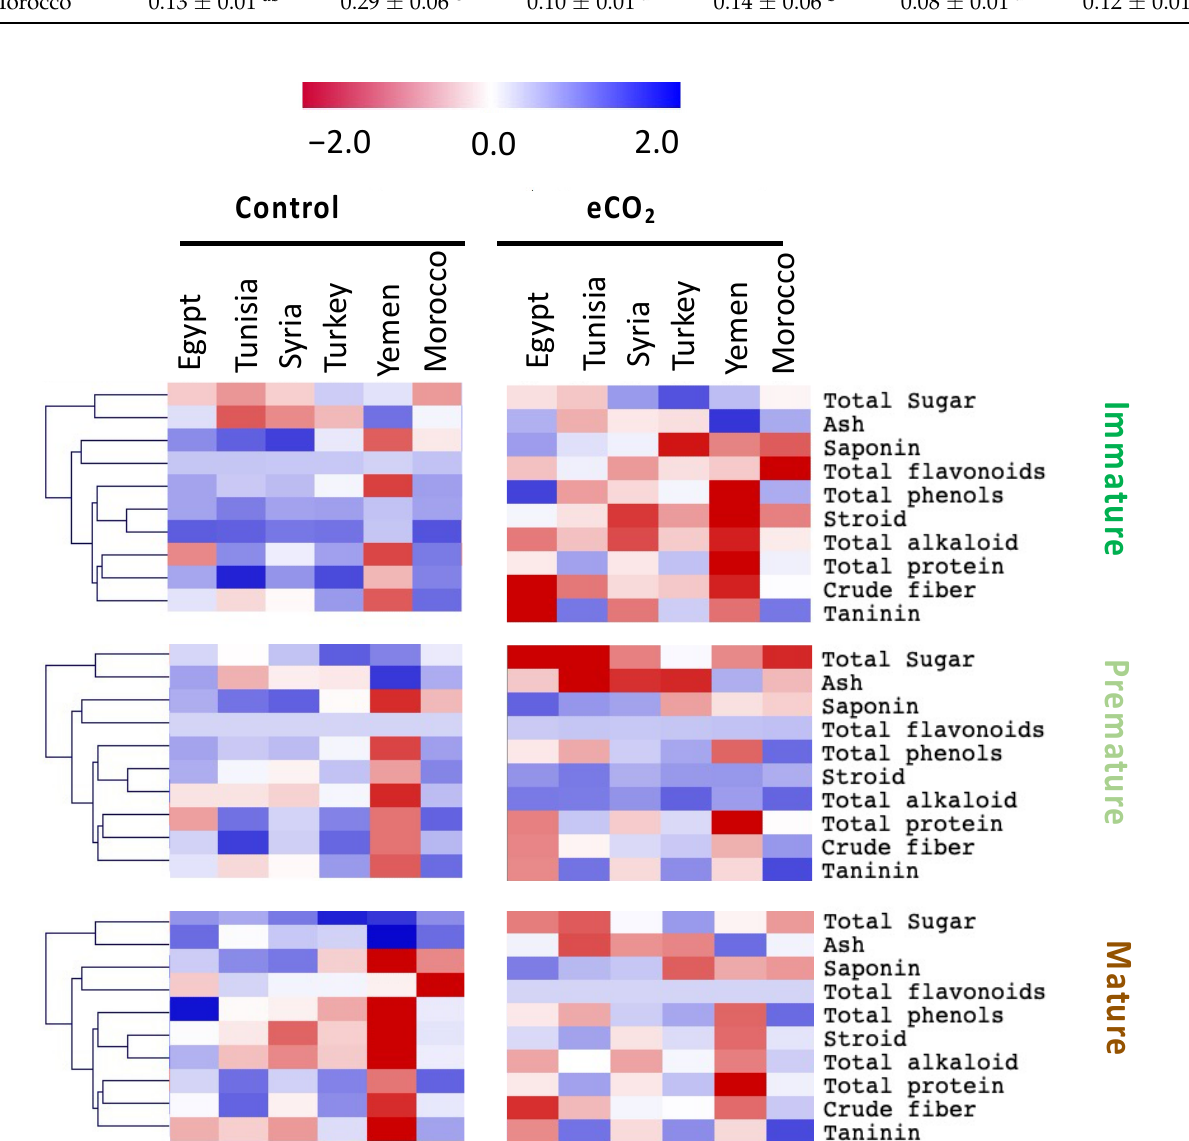
Figure 1. Heatmap showing the hierarchical clustering analysis of total nutrients of six Pimpinella anisum L. accessions at three seed developmental stages and under control and elevated CO 2 growth conditions. The level patterns are relatively demonstrated on the heatmap based on the mean value ( n = 5) for each parameter. Red and blue color gradients indicate higher and lower levels, respectively.